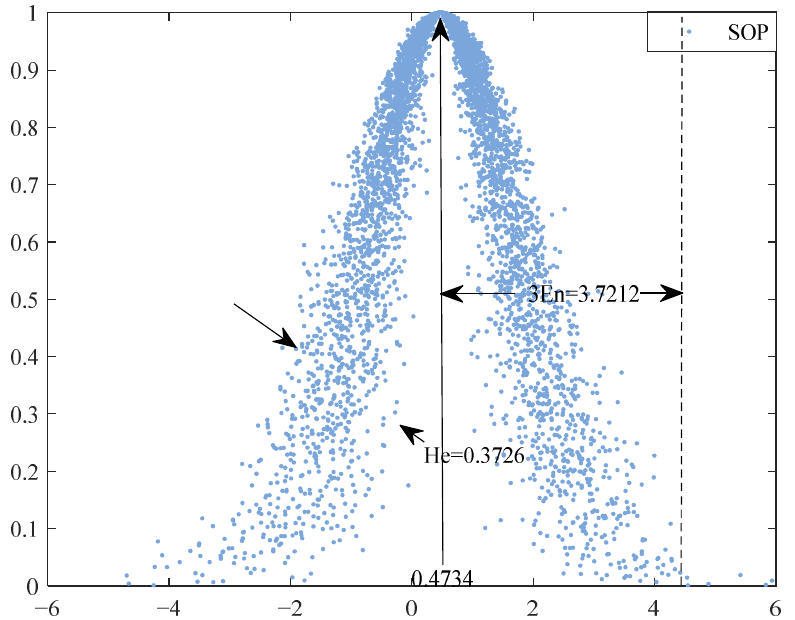
Figure 7. Cloud map for comprehensive evaluation in the short-term operation period (SOP).